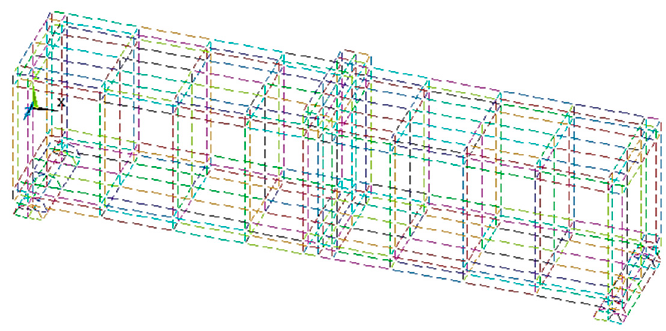
Figure 8. Typical idealization of the steel stirrups, top, and bottom bars.